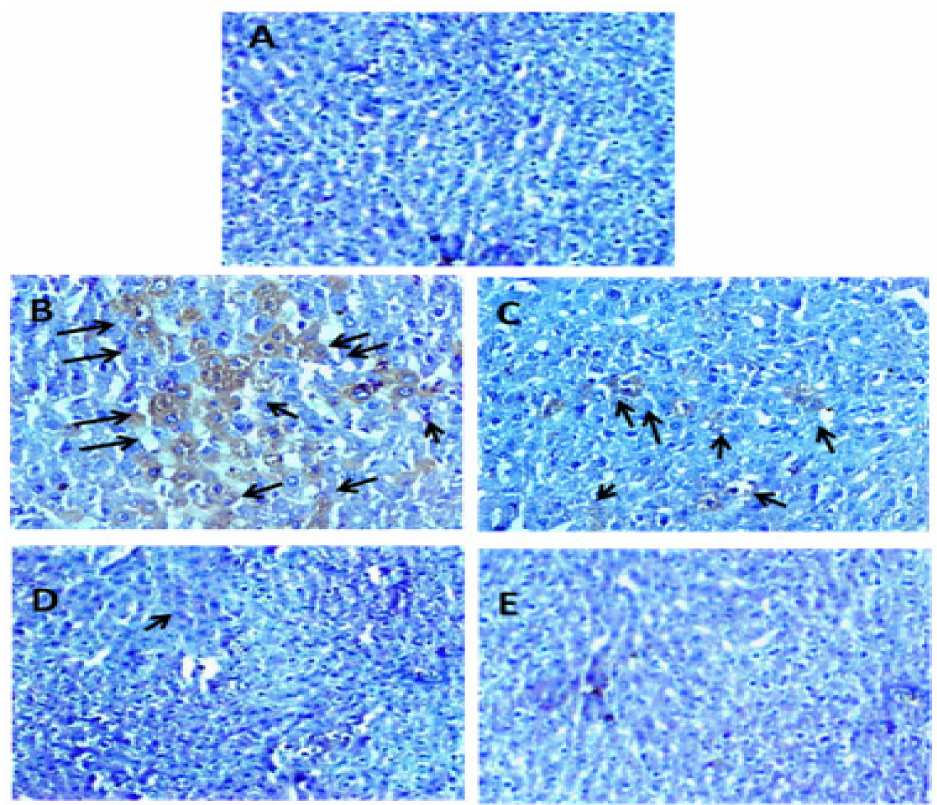
Figure 6. Immunohistochemical examination of hepatic sections depicting expression of NF- κ B. Carum carvi effect on acetaminophen-induced expression of NF- κ B in rat liver. ( A ) Healthy control rats (sections of liver). ( B ) Hepatic areas depicting higher expression of NF- κ B (arrows) in acetaminophen- administered rats. ( C , D ) Liver sections in groups treated with Carcum carvi (D1 and D2). ( E ) D2 treatment group (only Carum carvi ). Original magnification: 40 ×